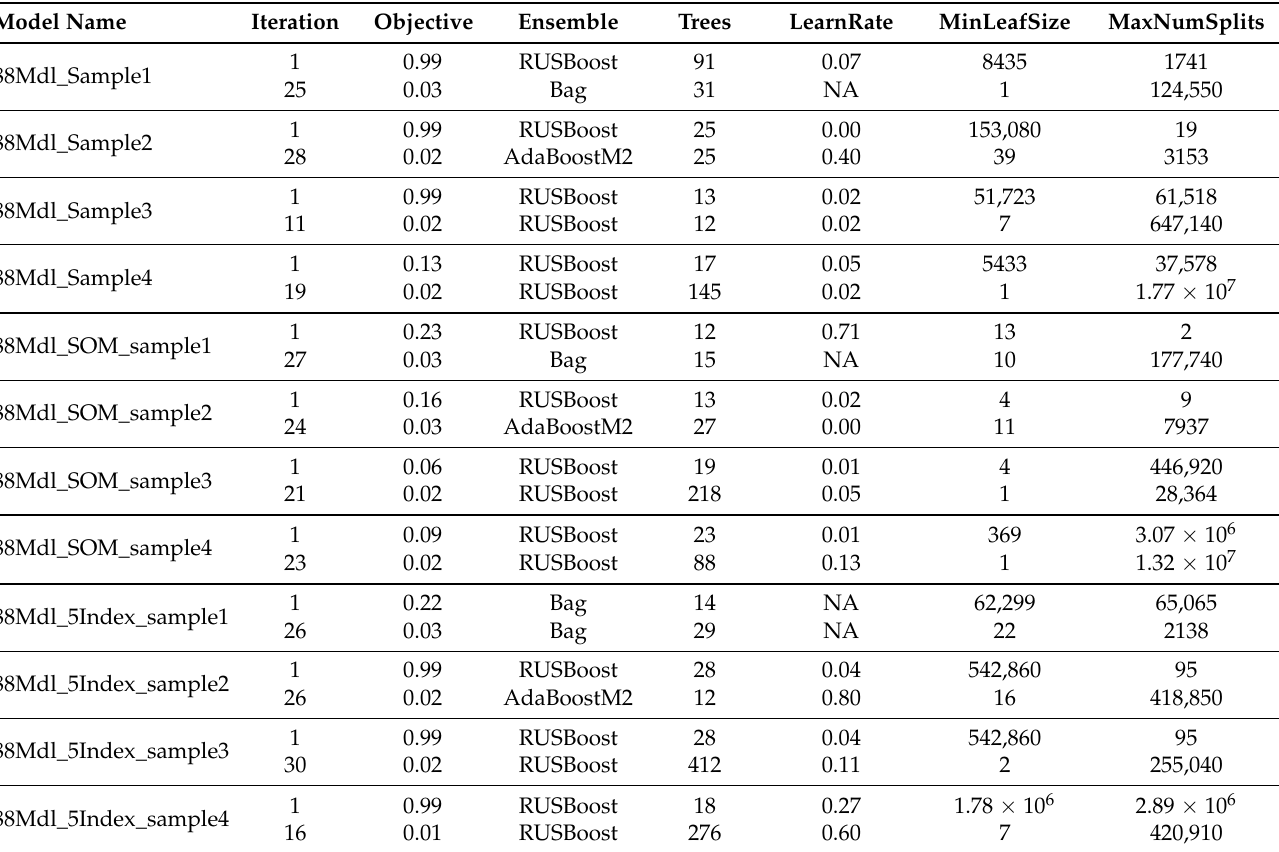
Table 9. Hyperparameters sensitivity